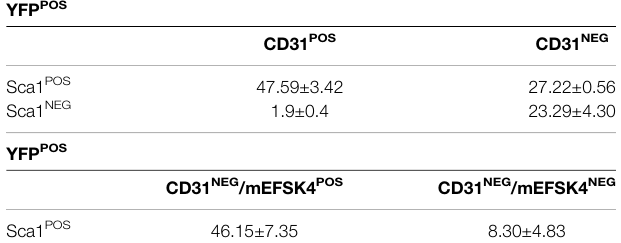
TABLE 3 | Percentage of Sca-1 POS cells included in both YFP POS and YFP NEG fractions into the different characterized subpopulations (mean ± s.e.m.).